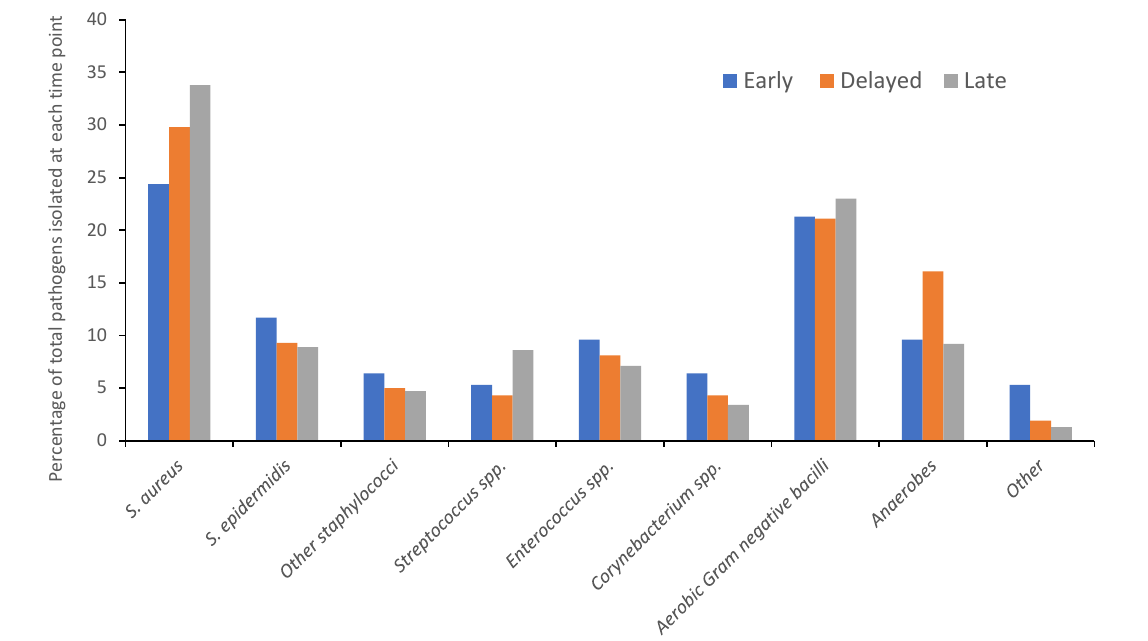
Figure 1. The distribution of pathogens isolated in early, delayed and late fracture-related infections.